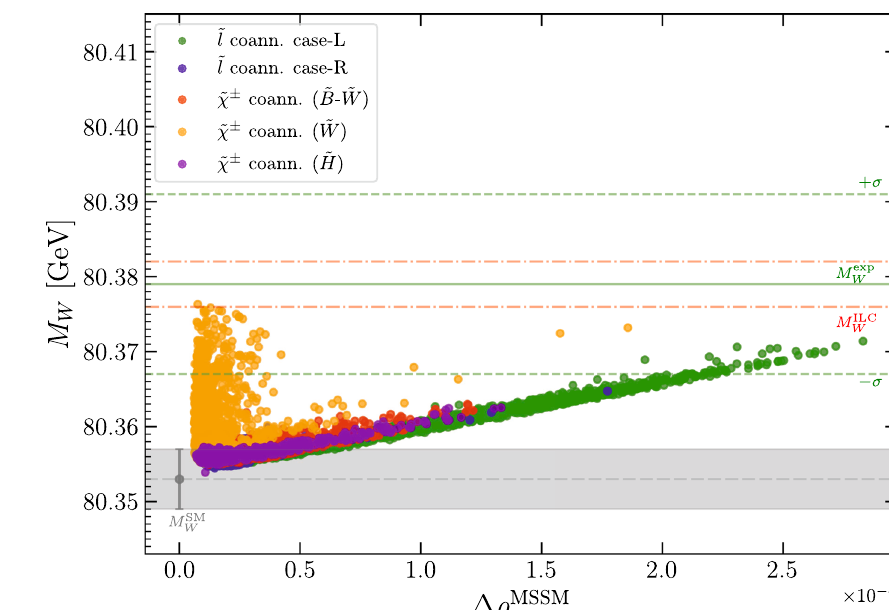
Fig. 2 Results for the five scenarios in the (cid:2)ρ MSSM – M W plane. The horizontal lines and the color coding are as in Fig.